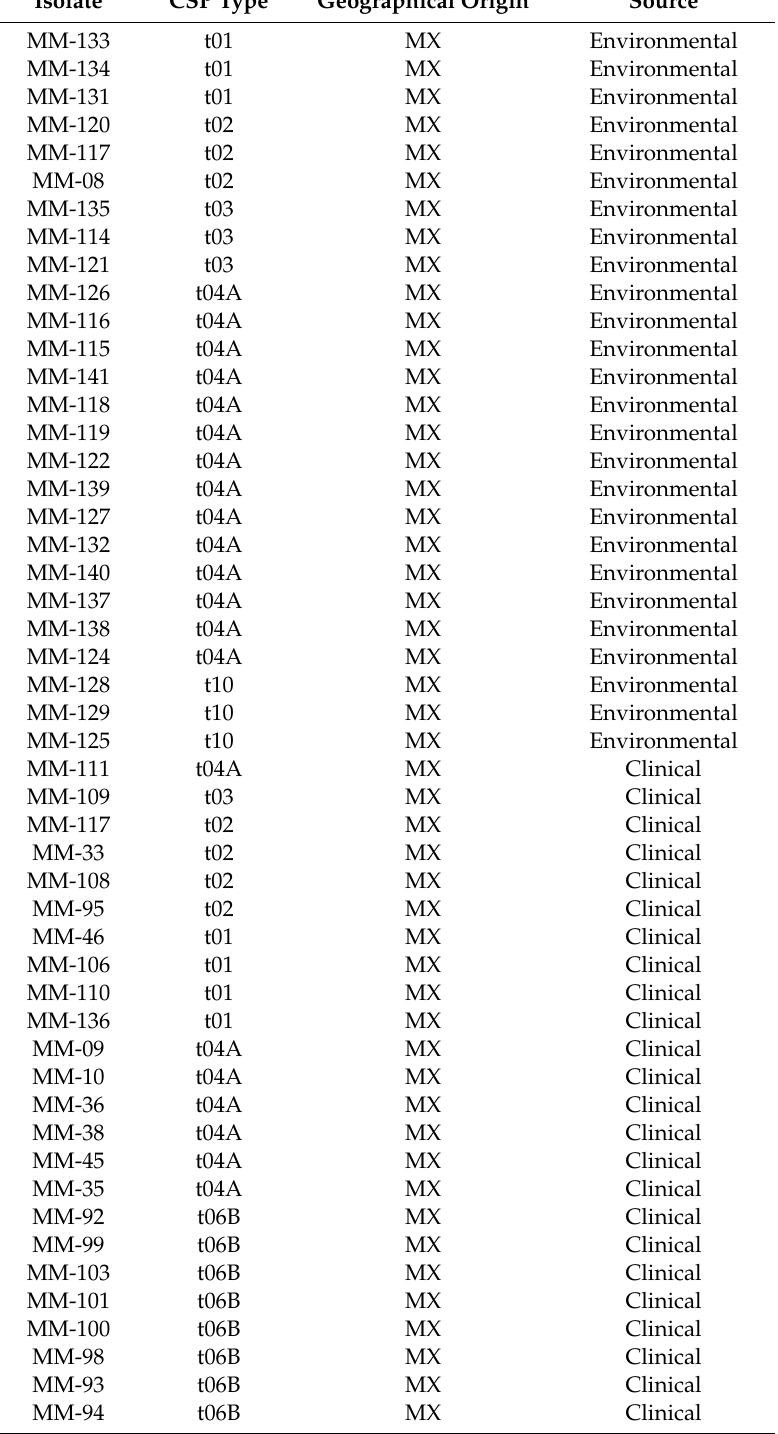
Table 1. CSP (cell surface protein) type, geographical origin, and source of Aspergillus fumigatus isolates. Isolate CSP